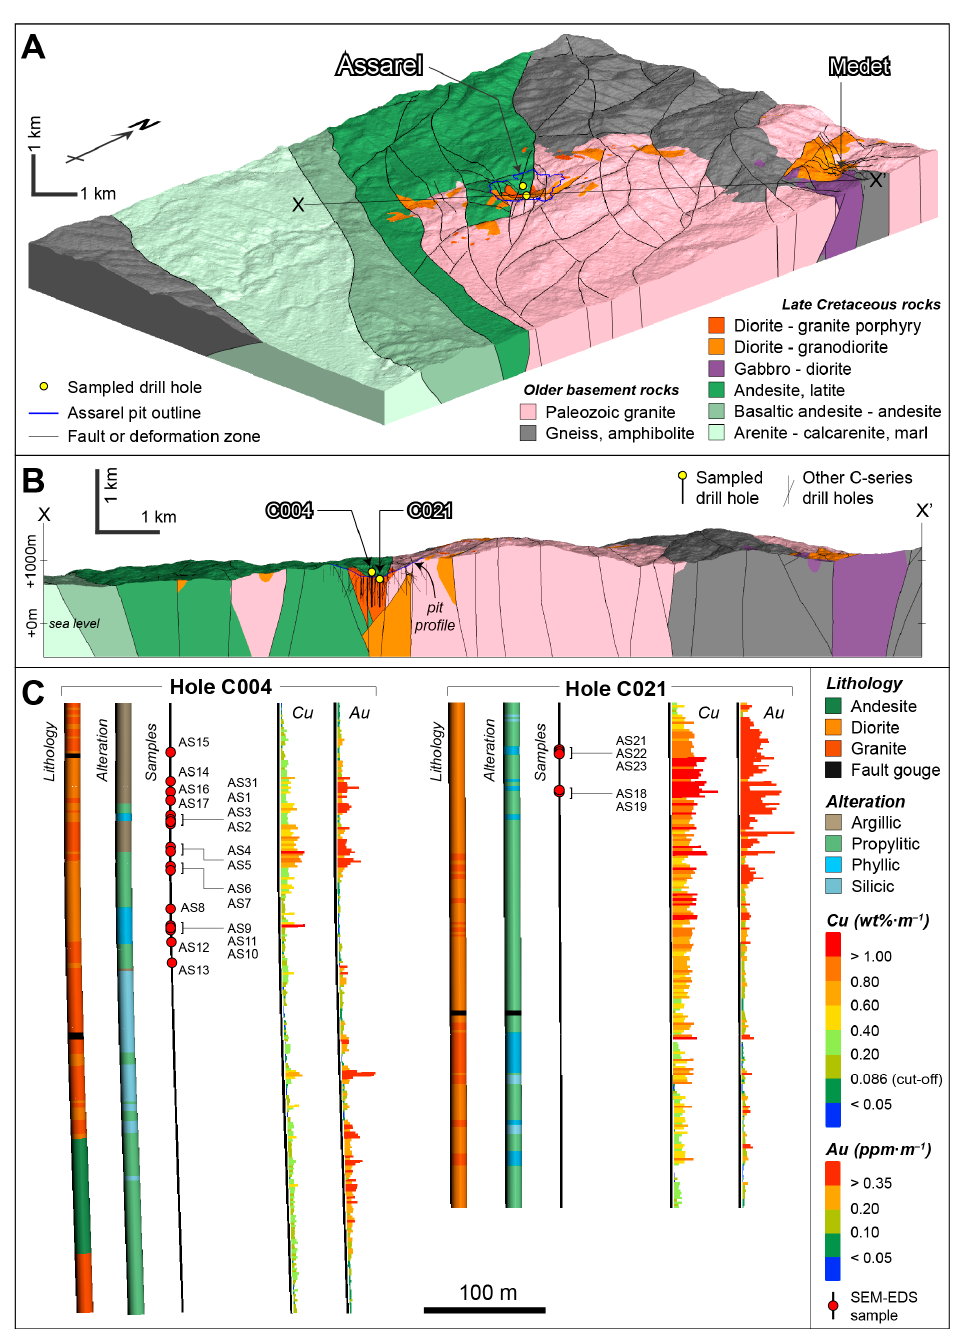
Figure 3. ( A ) 3D geological model of the Assarel-Medet area, looking to the northwest (partly based on Iliev and Katckov [55]). Outline of the Assarel pit is highlighted. ( B ) NE–SW cross-section through the Assarel-Medet area corresponding to profile line X-X’ shown in A (note scale di ff erence). Sampled drill holes C004 and C021 and other C-series drill holes also shown. Legend in ( A ) also applies to ( B ). ( C ) Schematic geological logs (looking to the NW) and Cu and Au grades for drill holes C004 and C021. The locations of 23 samples used for scanning electron microscopy–energy dispersive spectrometry (SEM-EDS) analysis also